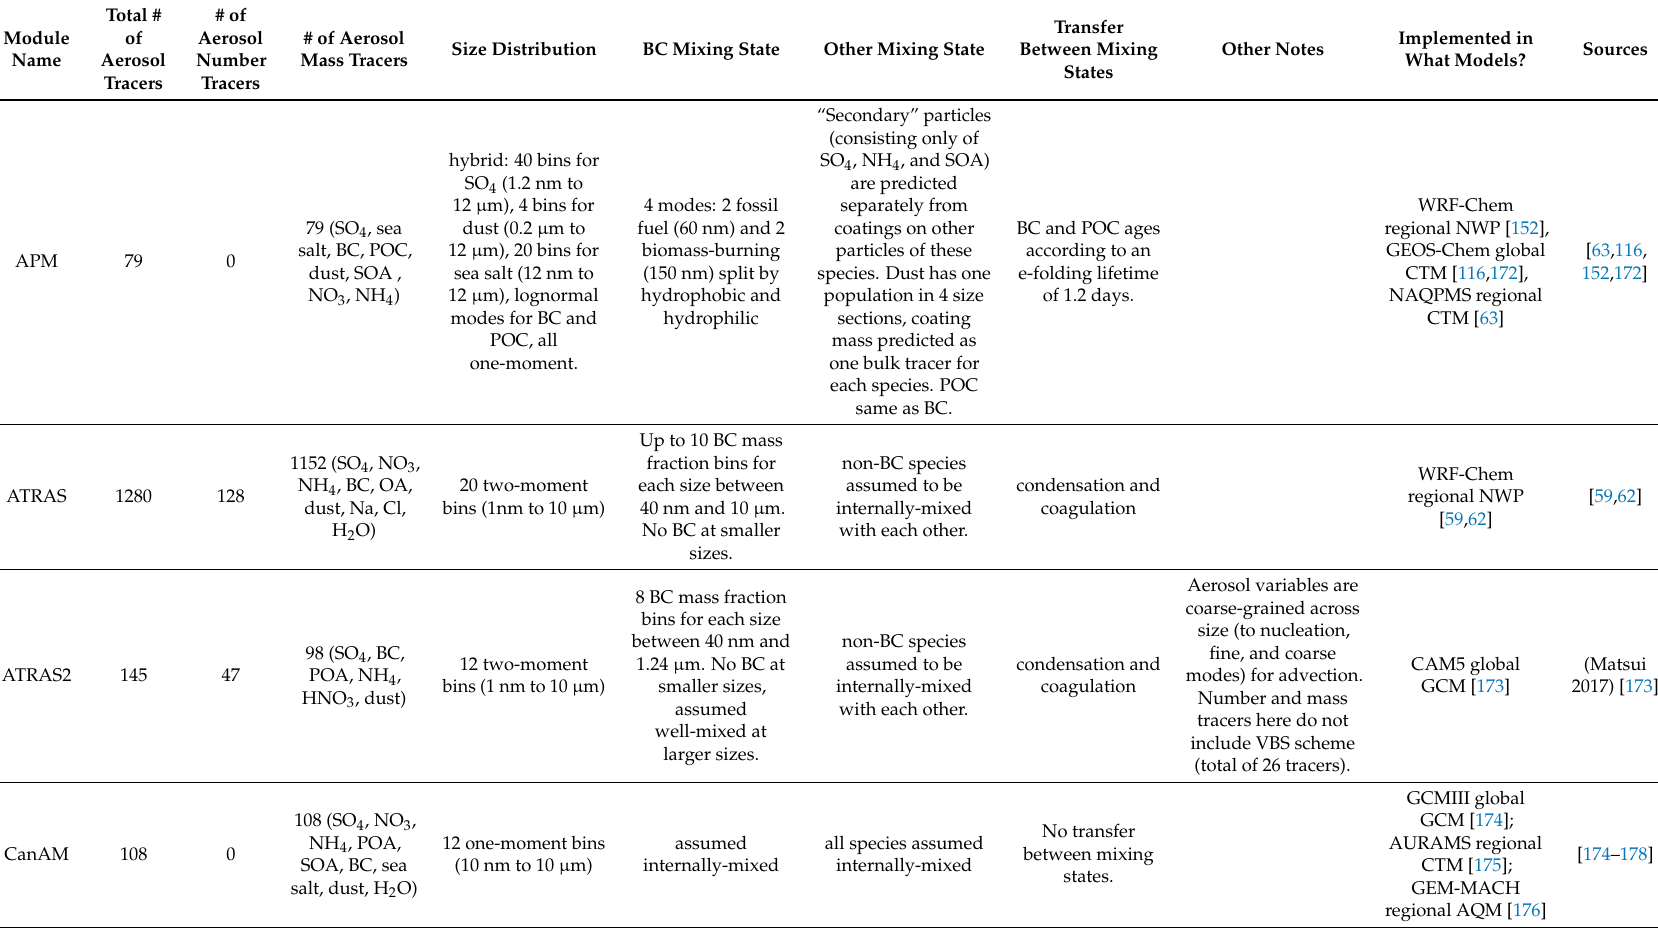
Table 1. Mixing state and size distribution representation in several aerosol modules. Please note that the listed information often depends on the specific configuration of each model, and should be taken as indicative only. Listed ranges of size distribution refer to particle